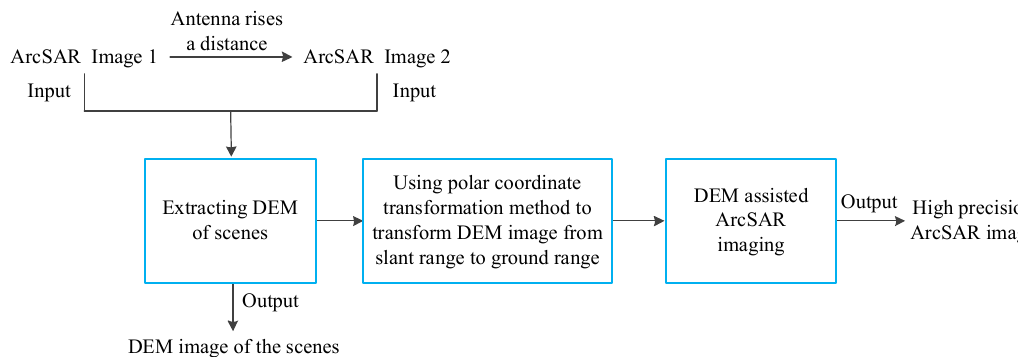
Figure 6. Flow chart of the proposed high precision ArcSAR imaging method.